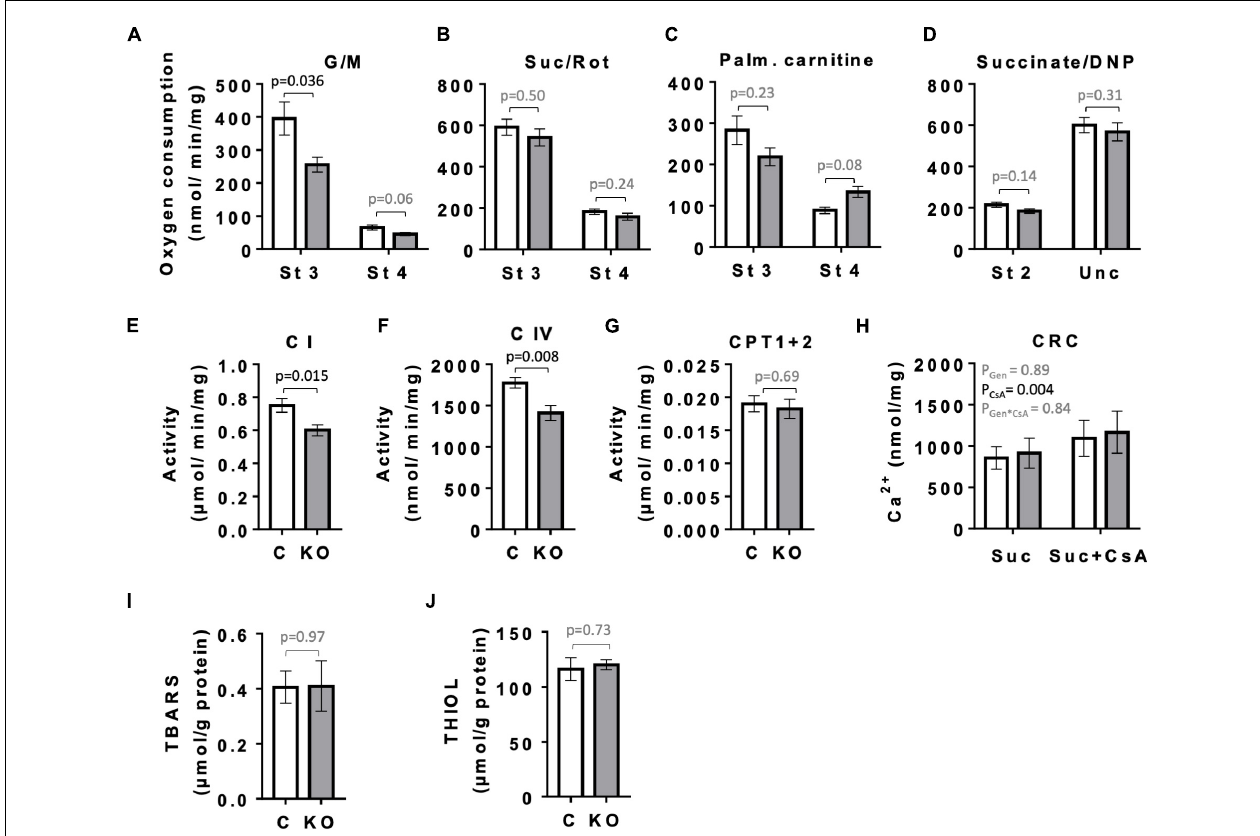
FIGURE 8 | Mitochondrial function and markers of oxidative stress in control and AMPK α 1 α 2-KO mice. (A–H) Function of cardiac mitochondria isolated 10 weeks after tamoxifen administration. State 3 and 4 respiration with glutamate and malate (A) , succinate in presence of rotenone (B) , palmitoylcarnitine (C) and DNP-uncoupled respiration with succinate as substrate (D) . Activity of mitochondrial enzymes: complex I (E) , complex IV (F) , carnitine palmitoyltransferase (G) . Calcium retention capacity (CRC) in presence and absence of cyclosporine A, CsA (H) . (I,J) Markers of oxidative stress 52 weeks after tamoxifen administration: TBARS (I) and THIOLS (J) . Control (white bar), KO (gray bar). Data are presented as means ± SEM; n = 5–13 (A–G) , 4–5 (H) , 10–13 (I) , 5 (J) . For (H) statistical analysis was done by 2-way Repeated Measure ANOVA; the resulting significance values are given for two main effects of genotype P Gen and presence of cyclosporine A P CsA , and their interaction P Gen × CsA . Other comparisons were performed either using t -test or in (A–C,E) Mann–Whitney test.